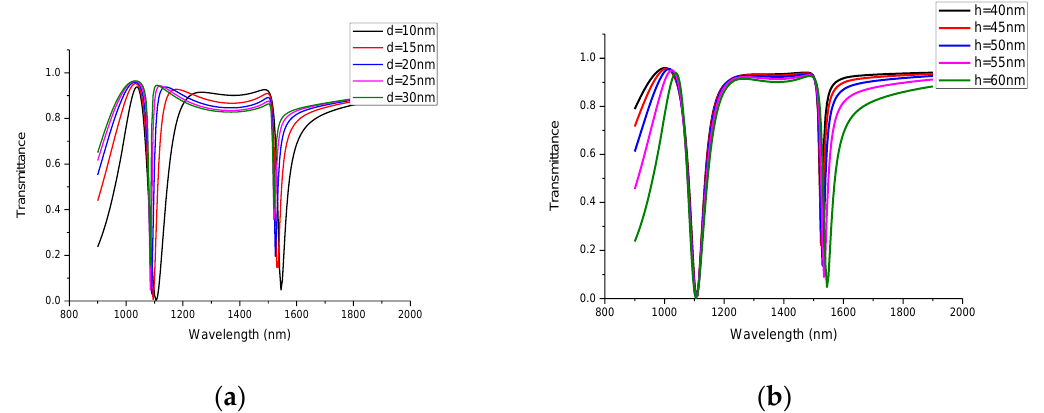
Figure 6. ( a ) Transmission spectrum of different coupling distances d ; ( b ) transmission spectrum of different heights of rectangular stubs h .